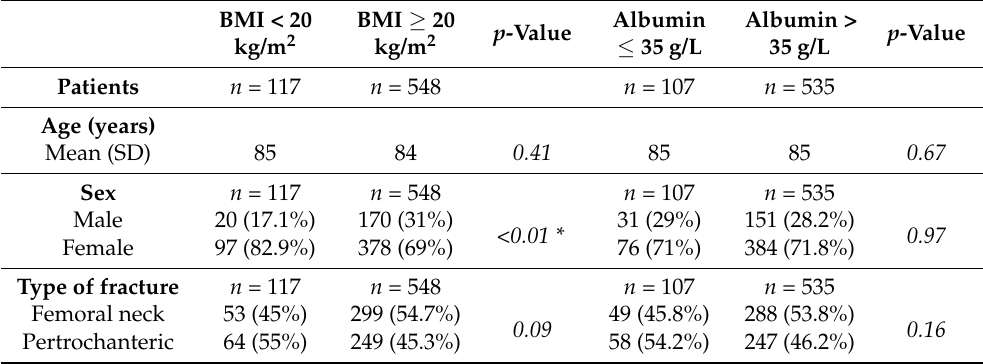
Table 2. Comparison of the baseline data between the patients with BMI greater or lesser than 20 kg/m 2 and albumin greater or lesser than 35 g/L. The number of patients with data is given separately for each parameter. HA, hemiarthroplasty; THA, total hip arthroplasty; ASA grade, American Society of Anesthesiologists; ISAR, Identification of Seniors At Risk; IQR, interquartile range; BMI, body mass index; mg, milligram; g, gram; kg, kilogram; m, meter; L, liter; dL, deciliter; CCI, Charlson Comorbidity Index. * significant